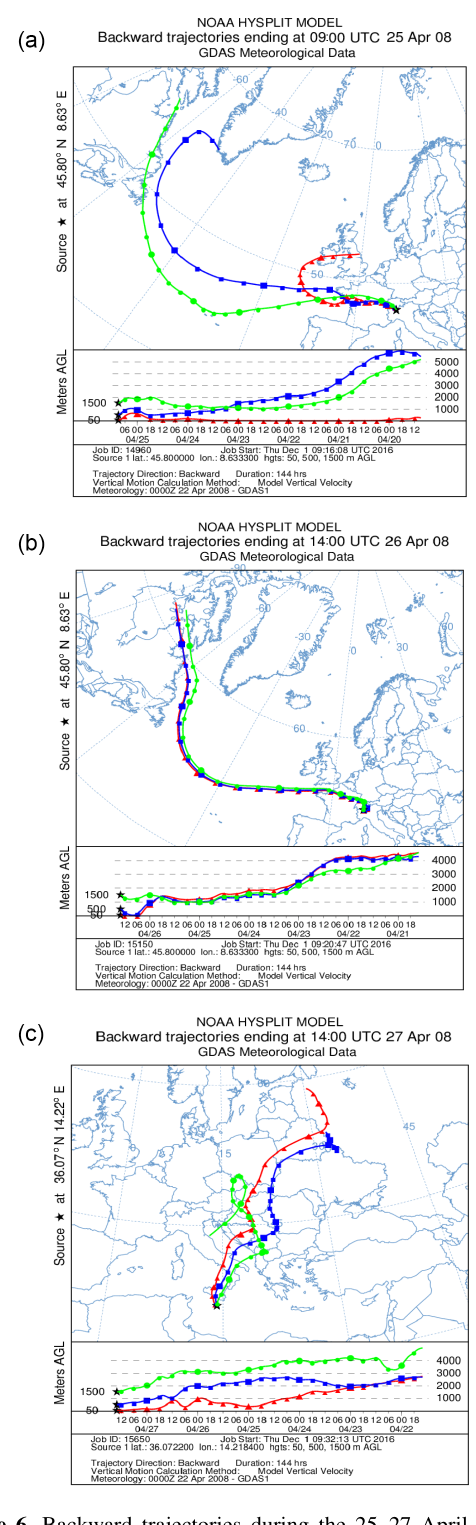
Figure 6. Backward trajectories during the 25–27 April episode ending at EMEP rural ozone stations in Italy (IT04, a, b ); and Malta (MT01, c